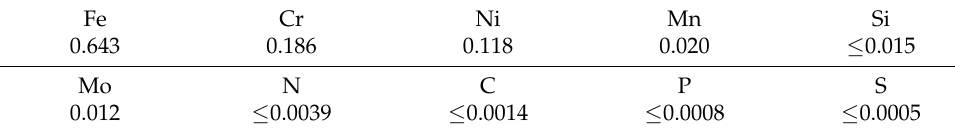
Table 2. Composition of Ni- and Cr-rich AISI-316L by atom